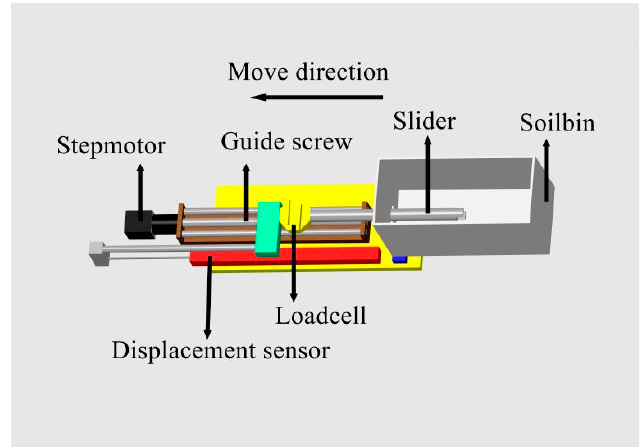
Figure 2. Schematic diagram of the equipment for the total buried resistance test.